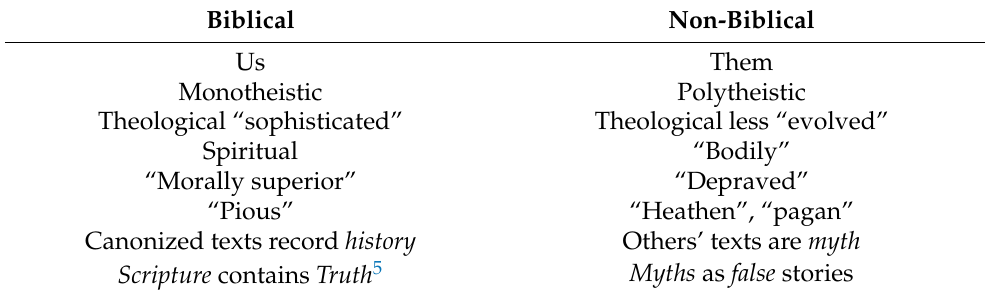
Table 1. Old Models: The Bible as Theological Truth and Accurate History as Opposed to Non-biblical Myth . Biblical